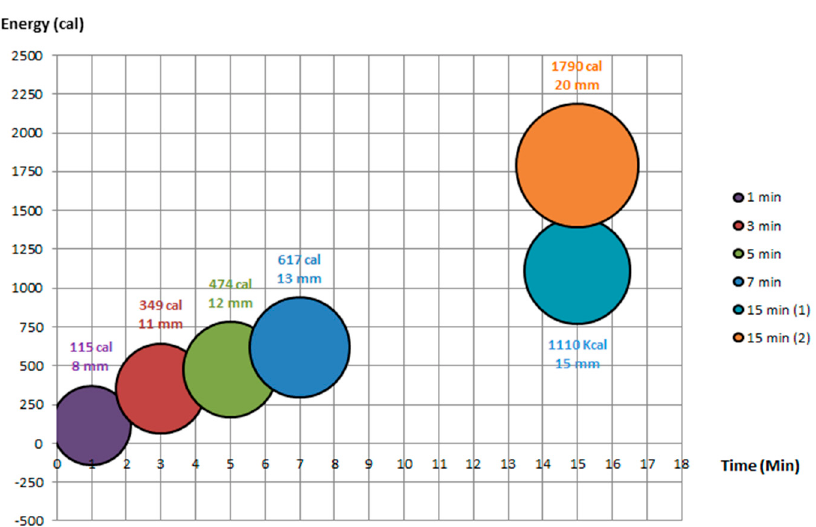
Figure 4. Increased delivered energy ( Y -axis) in hepatic tissue with ablation times ( X -axis) at 10 W of ablation power. Increasing the ablation time, the energy (“cal” above circles) increases, as well as the ablation area obtained (“mm” above the circle) after treatment.